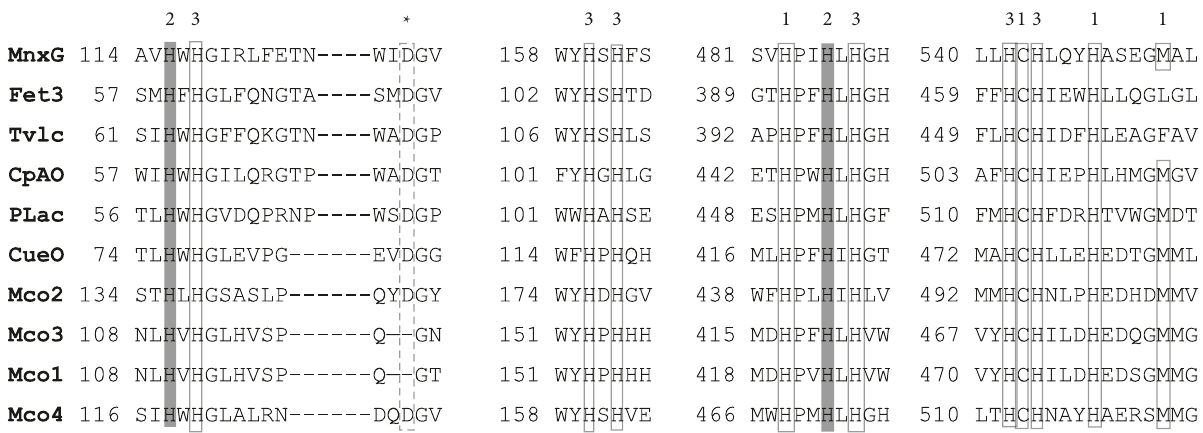
Figure 4: Homology of amino acid sequence around the copper-binding sites of type I Cu center and multi-copper oxidases of the strain Arthrobacter sp. PAMC25284. 1, 2, 3, and asterisk denote type I copper ligand, type II copper ligand, type III copper ligand, and proton donor, respectively. MnxG, dihydrogeodin oxide; Fet3, iron transport multi-copper oxidase; Tylc, Trametes versicolor laccase; CpAO, Cucurbita pepo ascorbate oxidase; Plac, Zea mays laccase; CueO, blue copper oxidase; and Mco1–Mco4, Arthrobacter sp. PAMC25284 multi-copper oxidase domain-containing